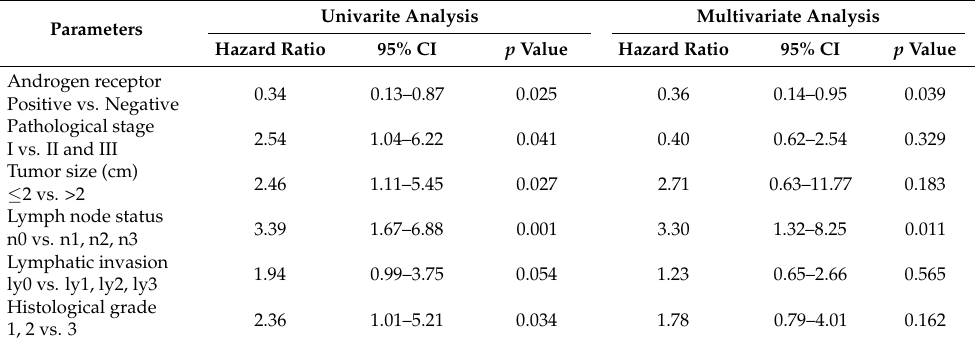
Univariate and multivariate analysis with respect to progression free survival in 190 triple-negative breast